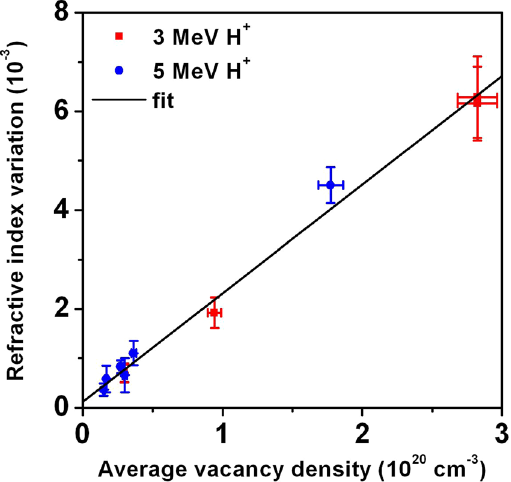
Figure 4. Refractive index variation. Plots of the average refractive index variation ∆ n measured at λ = 632.8 nm as a function of volumetric vacancy densities for both 3 MeV (red square dots) and 5 MeV (blue circular dots) proton irradiations. The black line reports the linear fitting of the whole